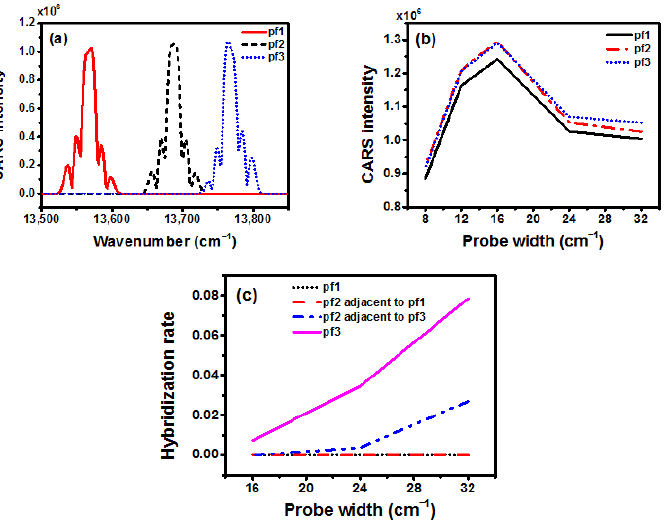
Figure A1. CARS spectra and the hybridization rate: ( a ) CARS spectra for d = 24 cm − 1 ; ( b ) influences of window width d of the probe light on CARS intensity and ( c ) on hybridization rate.